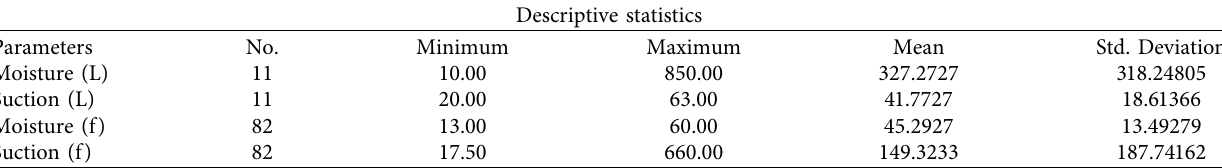
Table 4: Descriptive statistics for the measured parameters of Kohat expansive